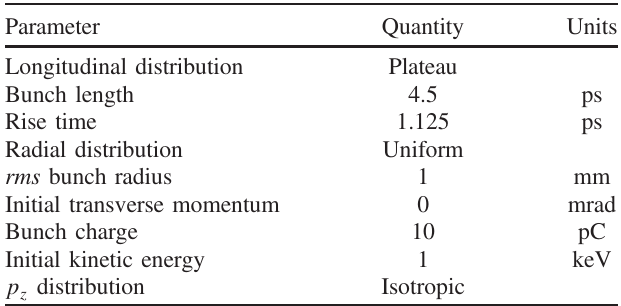
TABLE VI. Bunch distribution off the cathode.